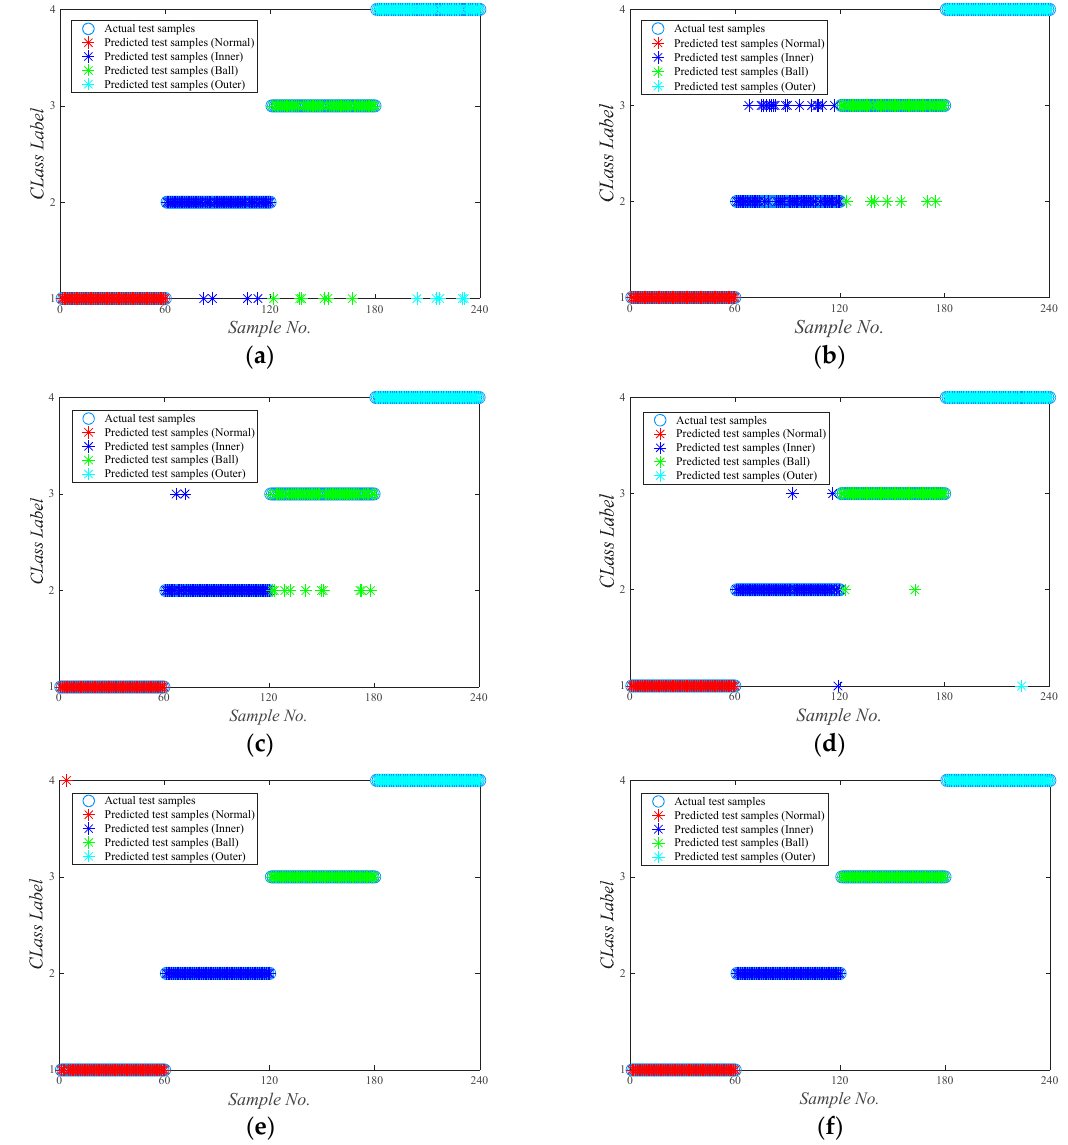
Figure 8. The classification results of the bearing data: ( a ) LLE; ( b ) LPP; ( c ) KPCA; ( d ) OLGPP; ( e ) LSPD; ( f ) ESBDP.